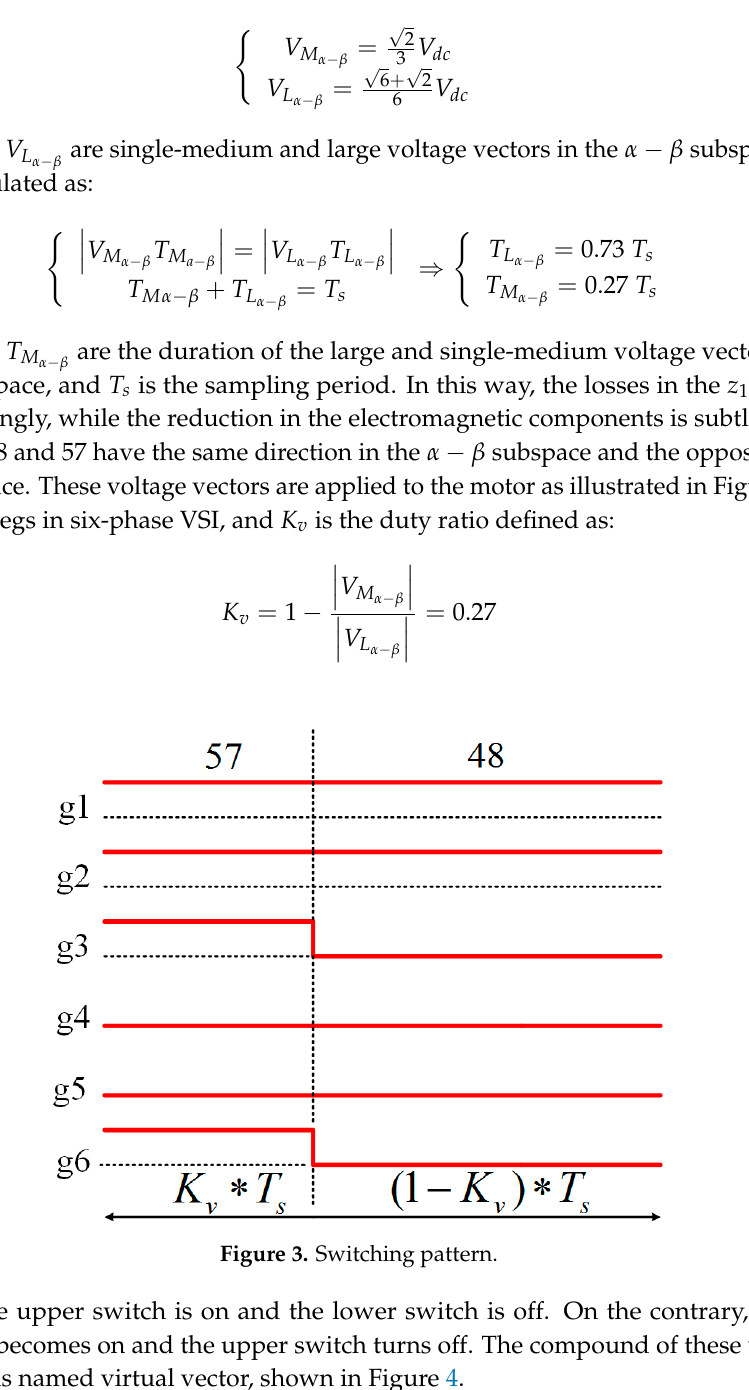
Figure 4. Virtual vectors in α - β subspace.